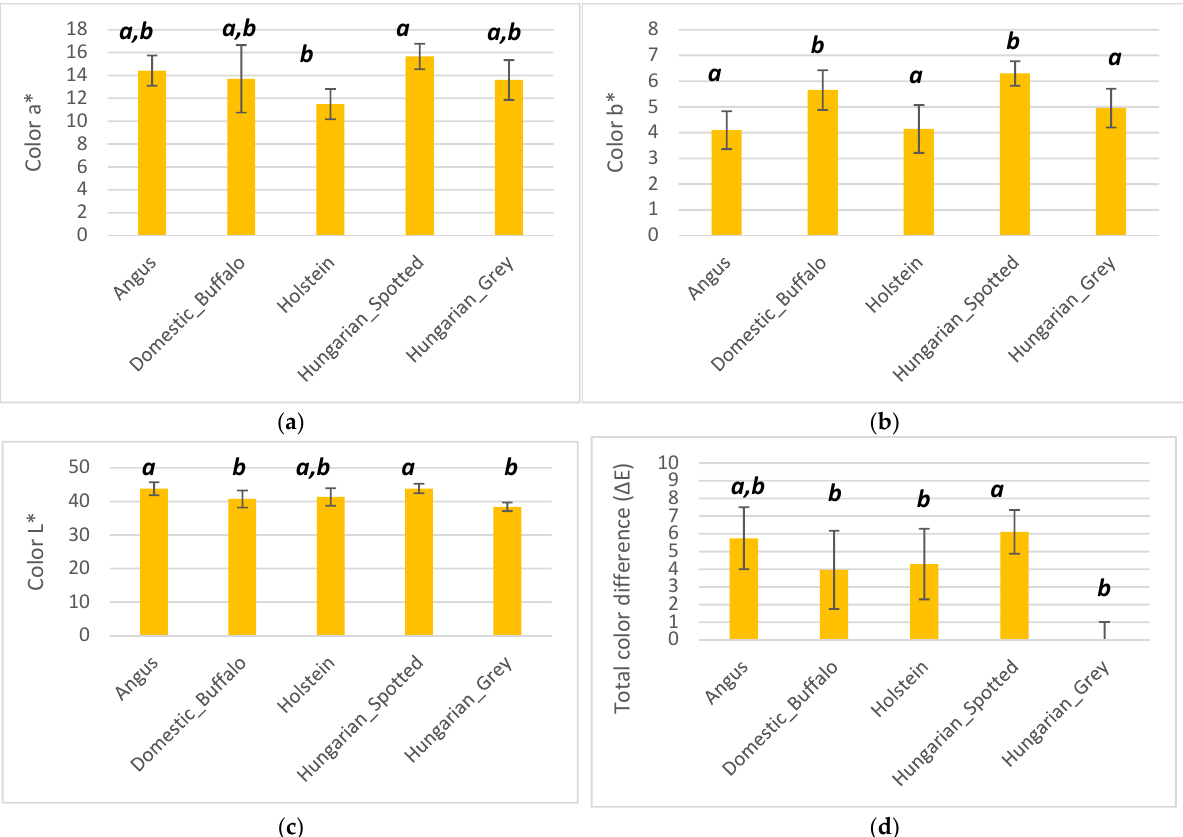
Figure 3. Bar plot showing the color a* ( a ), color b* ( b ), color L* ( c ) and total color difference ( d ) values of Angus, domestic buffalo, Holstein, Hungarian Spotted, and Hungarian Grey bovine breeds. Different superscripts imply significant differ- ences.